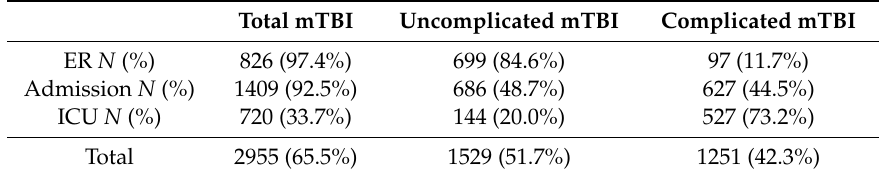
Table 1. Number of mild traumatic brain injuries (mTBIs), uncomplicated, and complicated mTBI per